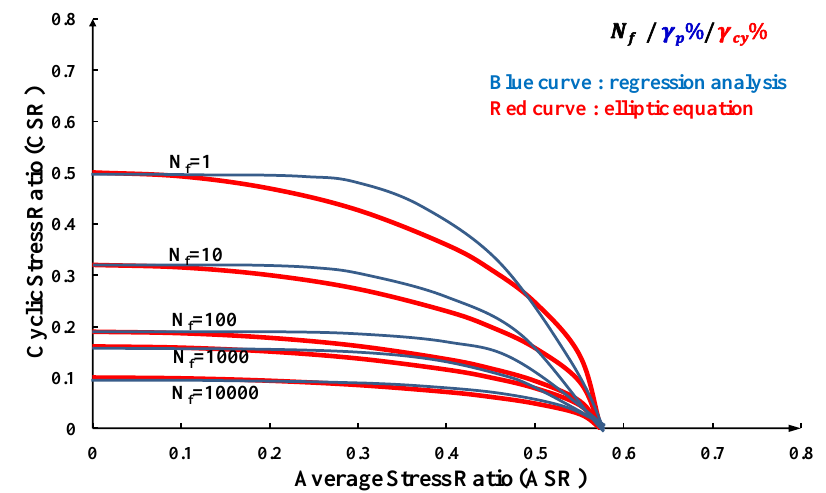
Figure 9. Design graph results: ( a ) Confining pressure 200 kPa, Relative density 50% [18]; ( b ) Confining pressure 300 kPa, Relative density 50% [21]; ( c ) Confining pressure 200 kPa, Relative density 85%.